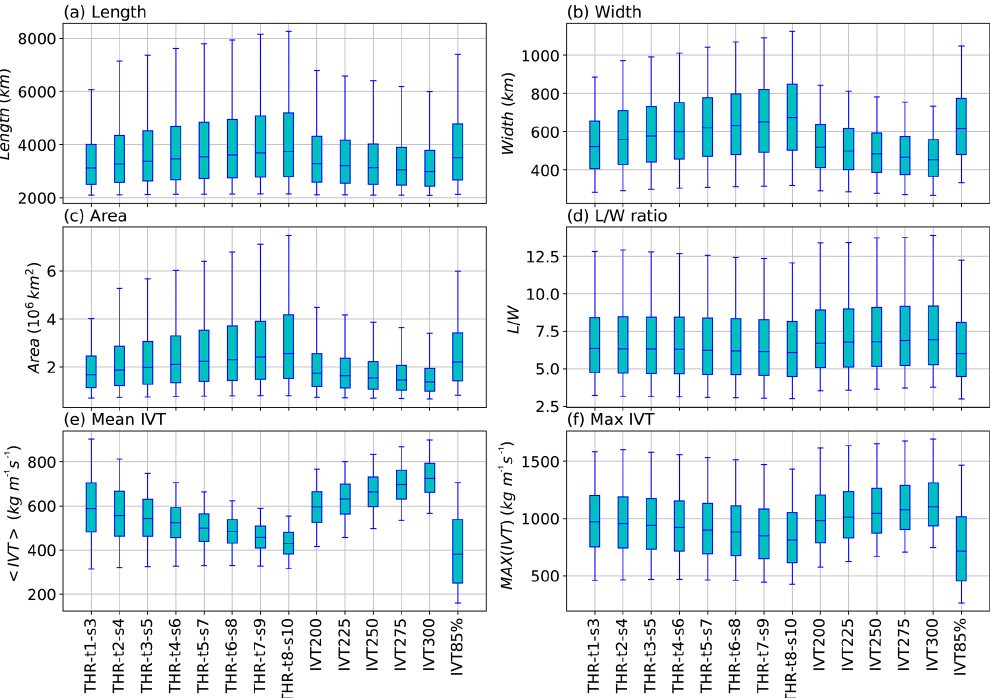
Figure 6. Distributions of (a) AR length (in km), (b) width (in km), (c) area (in 10 6 km 2 ), (d) length / width ratio, (e) mean IVT averaged over AR region (in kgm − 1 s − 1 ) and (f) maximum IVT within the AR region (in kgm − 1 s − 1 ) of ARs identified by different methods, during the period of 2004–2010. Box ends denote the interquartile range of the distribution, with the median as the line in the middle. Box whiskers denote the 5th and 95th